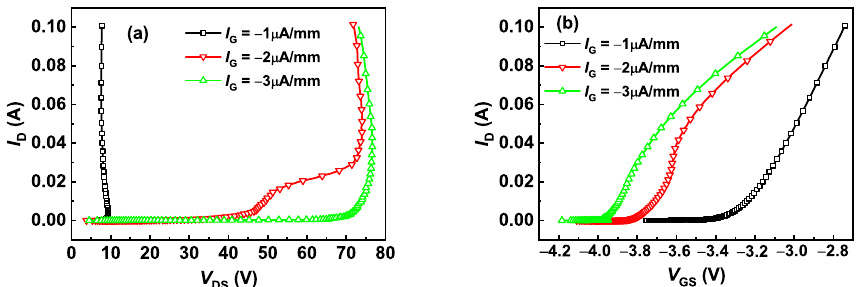
Figure 2. Room-temperature ( ∼ 20 ◦ C) BV ON loci of the 8 × (0.35 × 100) µ m 2 AlGaN/GaN HEMTs. ( a ) V DS versus I D . ( b ) V GS versus I D . Different constant currents ( − 1/ − 2/ − 3 µ A/mm) are extracted from the gate while I D is swept from the OFF-state ( − I G ) to the ON-state.